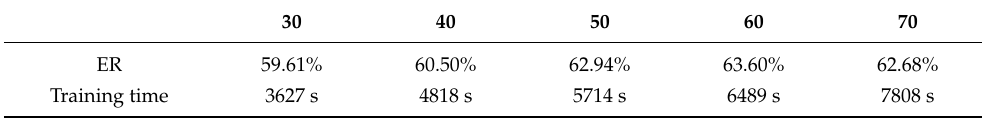
Table 6. Experimental results of parameter selection of epochs.